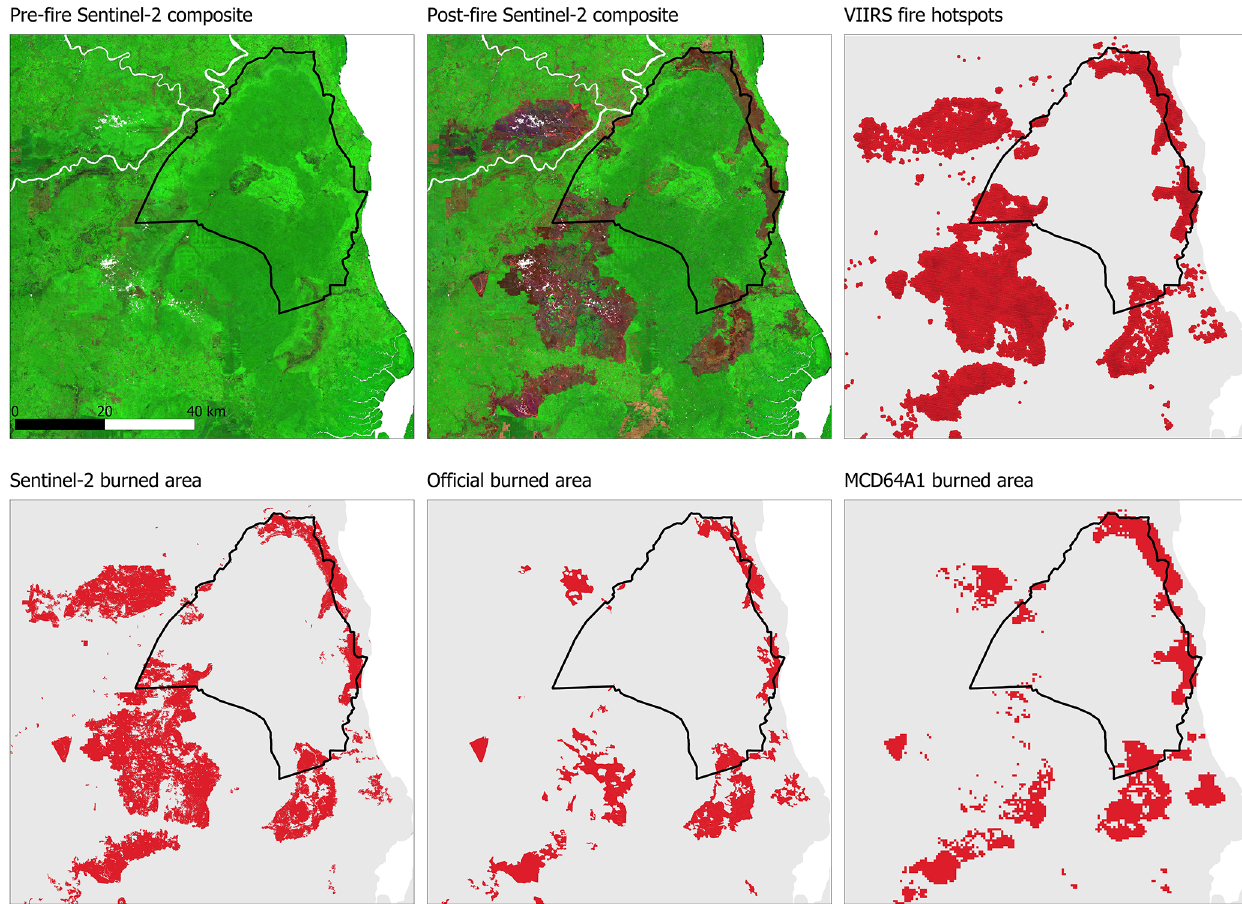
Figure 7. The pair of cloud-free pre- and post-fire Sentinel-2 composites over Berback National Park (black line) and surrounding areas in Jambi Province (see also Inset A, Fig. 1), revealing large burned areas around Berbak National Park (areas that have transitioned from green to dark brown/red tones). These large burn scars have been detected by VIIRS hotspots and by the Sentinel-2 burned-area map, but some have been missed by the official and MCD64A1